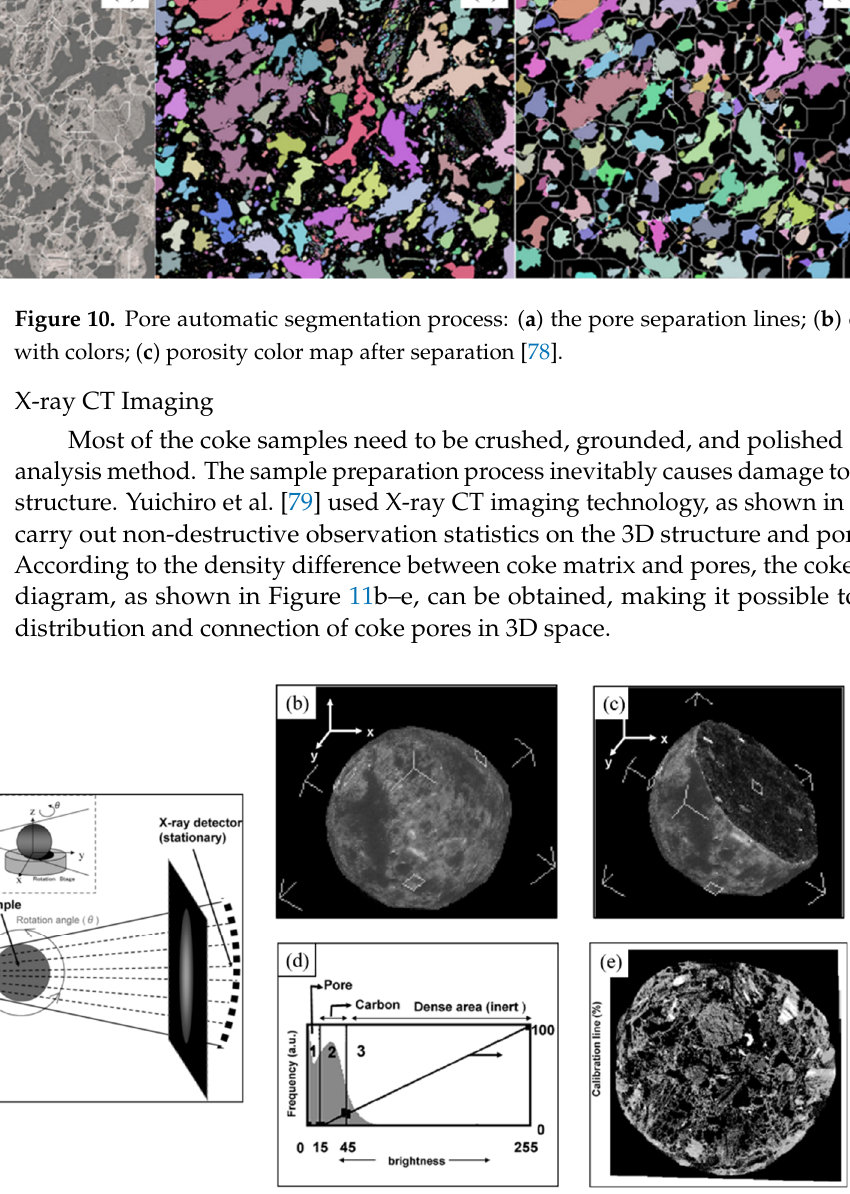
Figure 11. X-ray CT imaging process: ( a ) schematic diagram of X-ray CT; ( b ) 3D scanning of a spherical coke; ( c ) section diagram of a spherical coke; ( d ) picture brightness adjustment; ( e ) coke CT image [79]. Copy right CC BY-NC-ND 4.0.